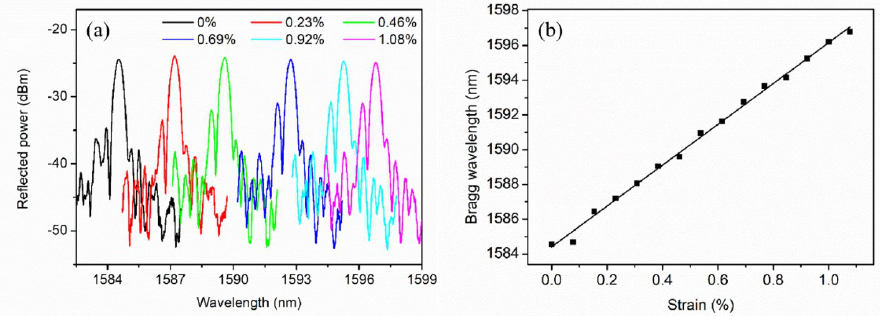
Figure 6. The spectrum ( a ) and Bragg wavelength shift ( b ) in terms of the strain from 0% to 1.08% for FBG 1 in the first regime.